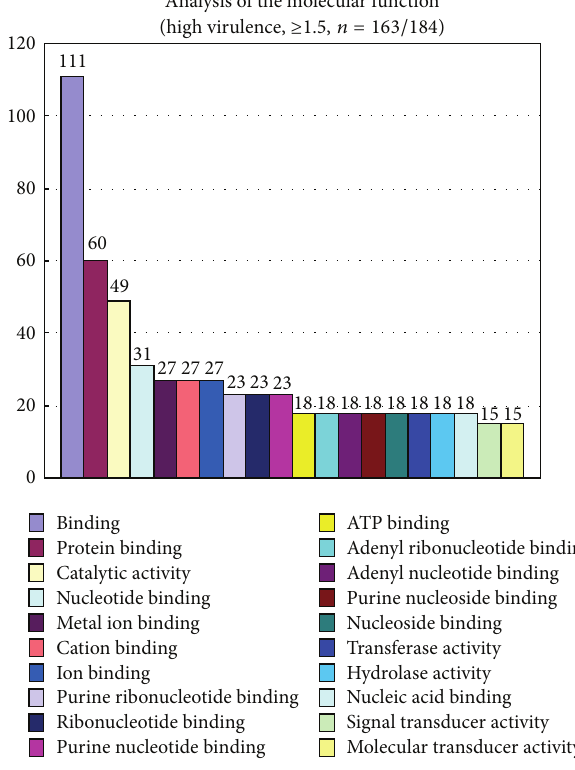
Figure 14: Analysis of the molecular function of stored genes was conducted using the Biological Networks Gene Ontology tool (BINGO, http://www.psb.ugent.be/cbd/papers/BiNGO/) to identify statistically overrepresented GO categories among the biological data.Forthe184genesupregulatedonlyinthelungsofmiceinfected with C. gattii TIMM 4097, 163 terms related to molecular function- ing were detected, and GO terms related to binding accounted for about 75% of all